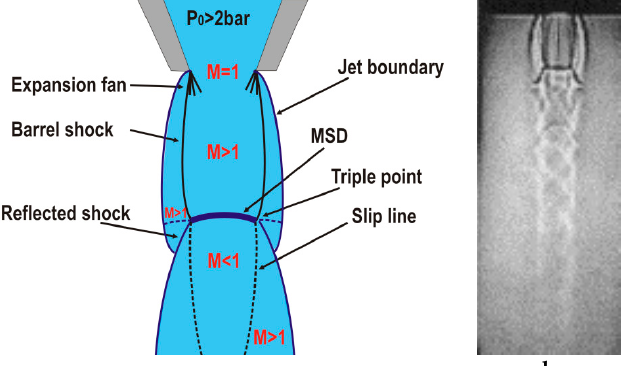
Figure 4. ( a ) Scheme and ( b ) shadowgraph image of the free jet emerging from a conical nozzle commonly used in laser fusion cutting for an operating parameter range p e / p a > 1.89. Adapted with permission from [23]; Copyright 1998 Elsevier